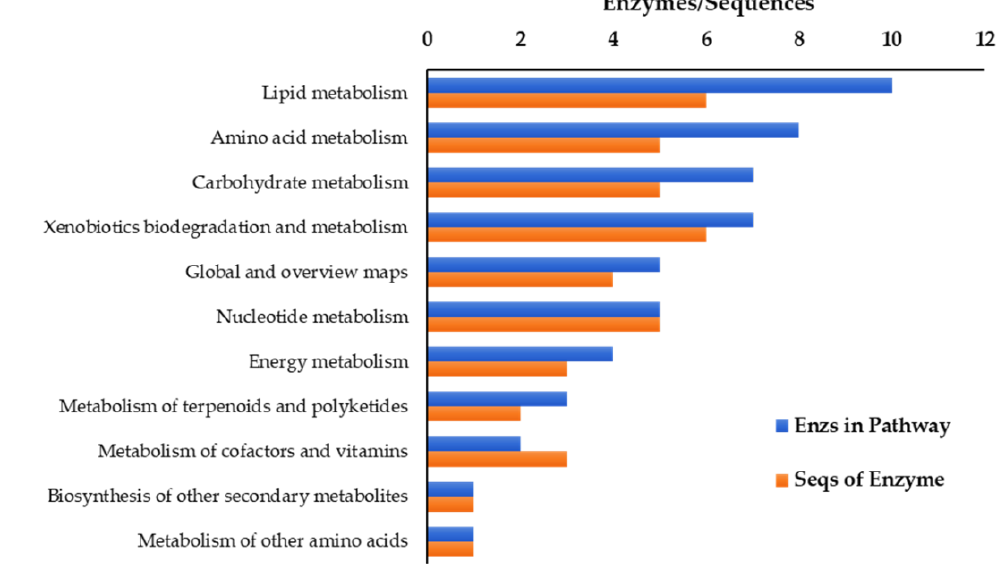
Figure 2 . Distribution of protein function compared between the InterPro Scan and Panther data- bases .